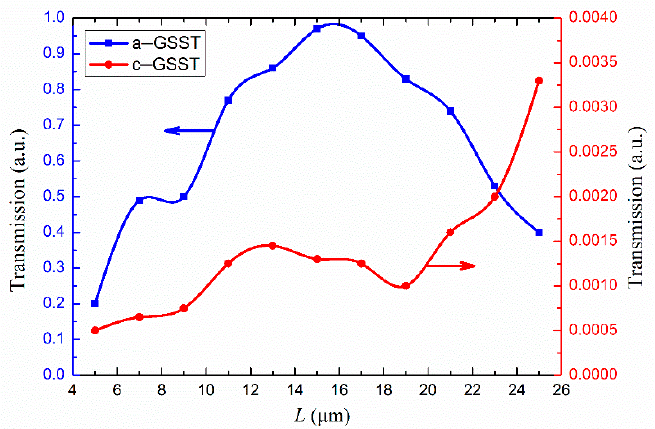
Figure 6. Normalized transmission of TE mode in racetrack MMR as a function of the coupling length L , when GSST is in amorphous and crystalline states, respectively.